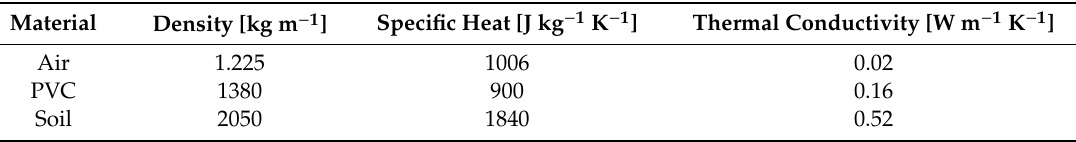
Table 2. Material properties